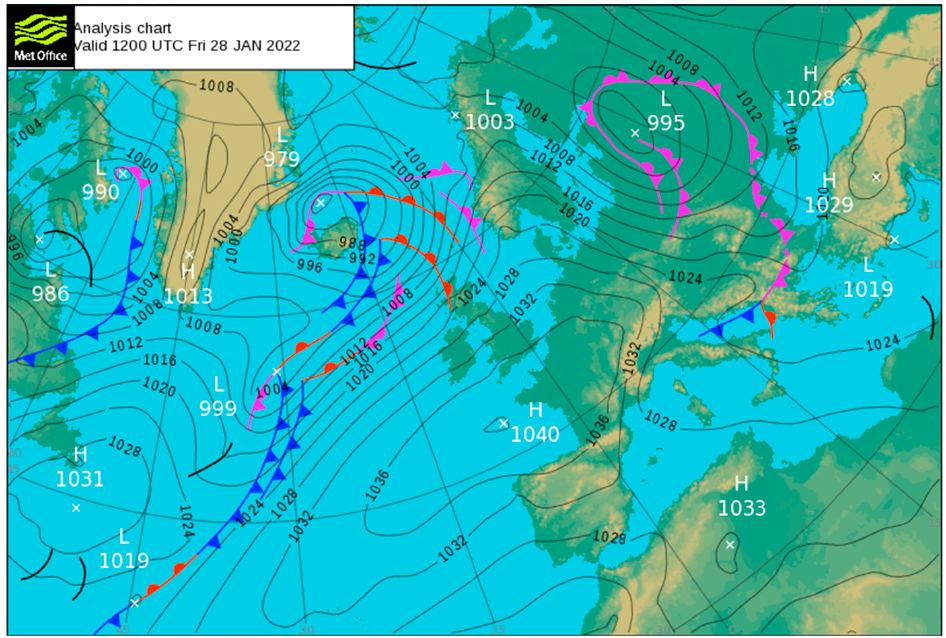
Figure 3. Synoptic chart of surface pressure showing the large-scale pattern over Europe on 28 January 2022 at 1200 UTC. Figure indicates the mean sea level pressure (black contour), cold front (blue line), warm front (red line) and occluded front (purple line). Source: [30].